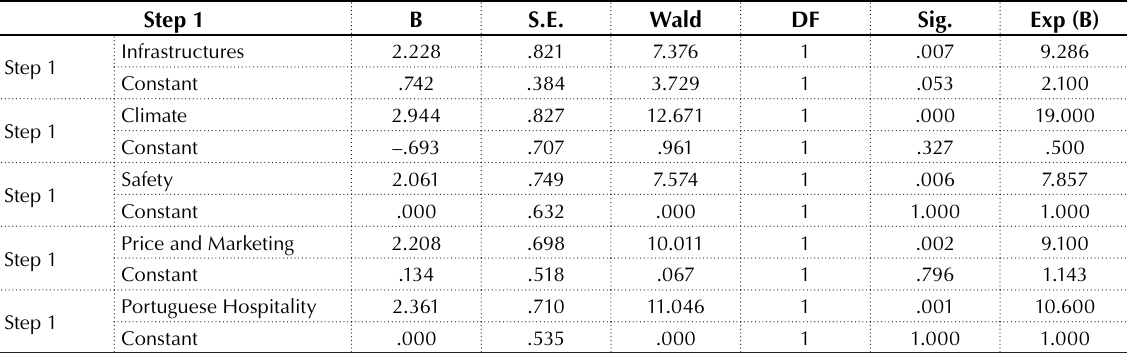
Table 1. One by one variables in the equation